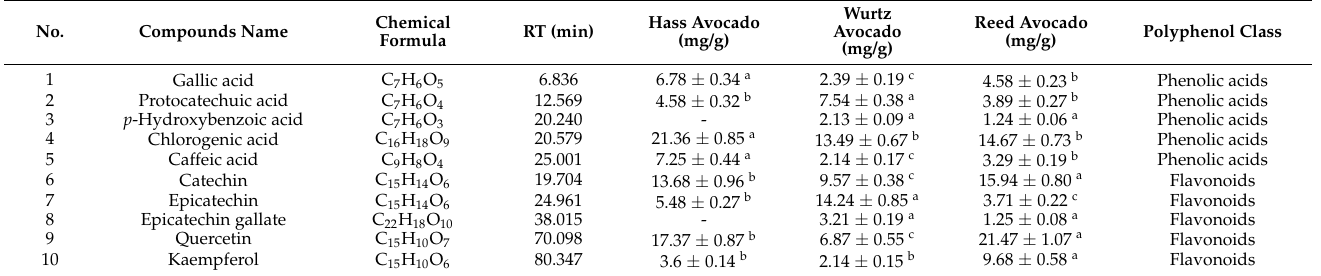
Table 3. Quantification of phenolic compounds in rejected avocados by